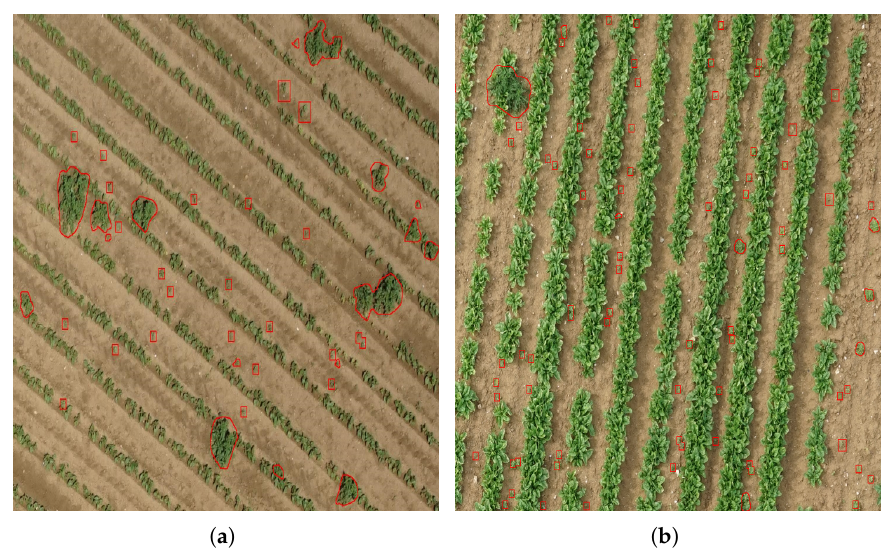
Figure 8. Parts of the bean field ( a ) and the spinach field ( b ) with the weeds labeled manually by an expert in red. The manual labeling took about 2 working days.